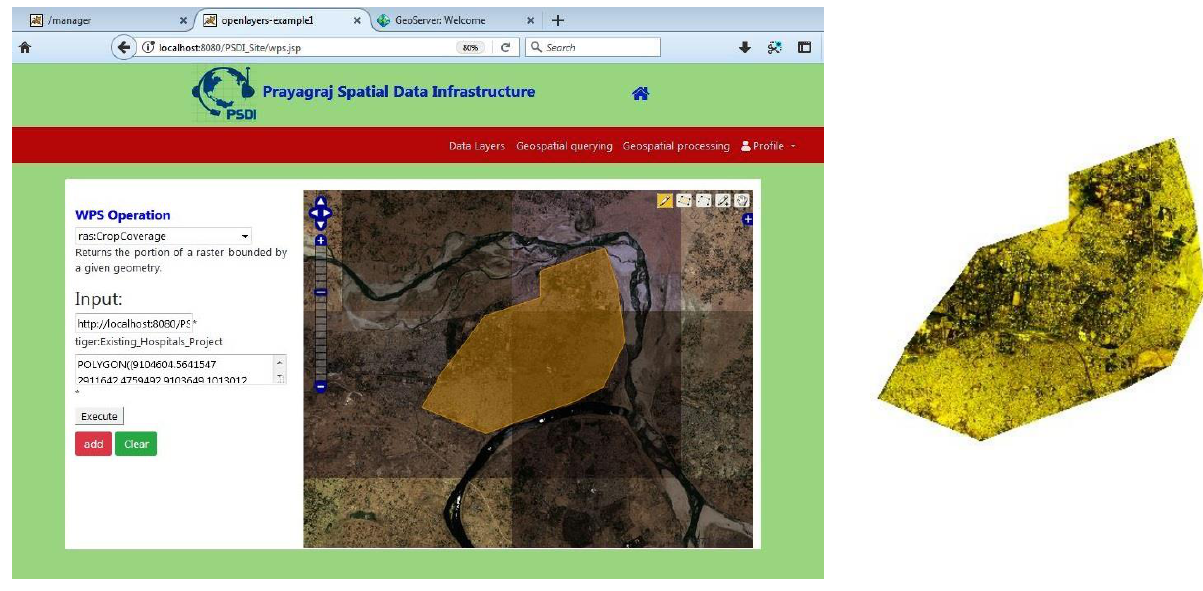
Figure 4(a). WPS based buffer operation performed on public health SDI Figure 4(b). Result of buffer operation